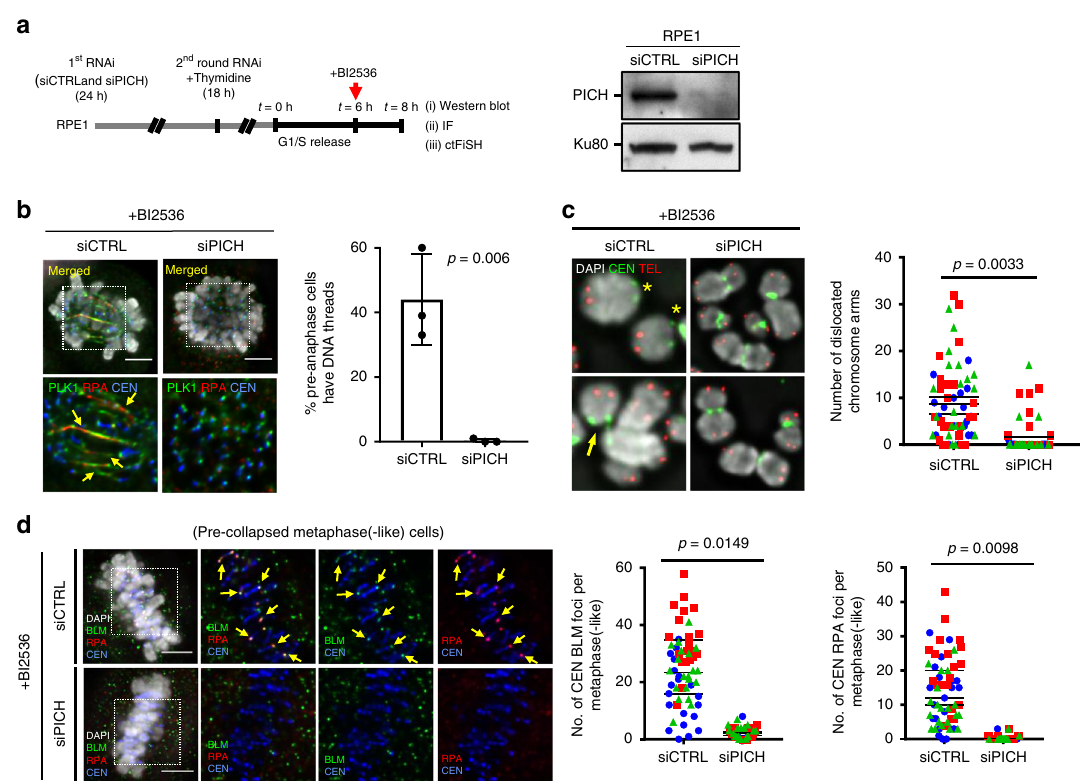
Fig. 7 PICH acts upstream of BLM in centromere disintegration. a Experimental outline of RNAi depletion, in combination with thymidine synchronisation and drug treatment. Right: western blot showing PICH protein level in siCTRL and siPICH treatment. Ku80 is used as a loading control. b Centromeric DNA thread formation in siCTRL and siPICH cells under BI2536 treatment. Quanti fi cation of DNA thread formation in RPE1 cells after siCTRL and siPICH treatment ( n = 3 independent experiments analysing 315 and 314 cells in siCTRL and siPICH conditions, respectively; mean ± S.D. is shown). c Representative images of mitotic spread chromosomes from cells prepared in ( a ) showing centromere dislocations (asterisks) and partial centromere splitting (arrow). Quanti fi cation of centromere dislocation is shown at right ( n = 3 independent experiments analysing 64 and 61 dislocated chromosome arms in siCTRL and siPICH conditions, respectively; means of each experiment are shown). d Reductions of BLM and RPA foci formation at centromeres in siPICH cells after BI2536 treatment. Representative images (left) and quanti fi cations (right) are shown ( n = 3 independent experiments analysing a total of 60 cells in each treatment; means of each experiment are shown, Scale bars = 5 μ